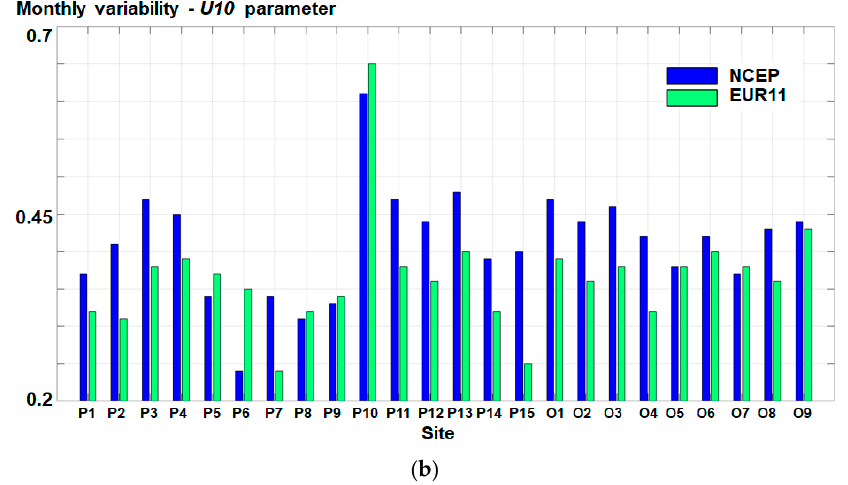
Figure 8. The variability of U10 from NCEP and EUR11 databases computed in each site: ( a ) seasonal variability; and, ( b ) monthly variability.